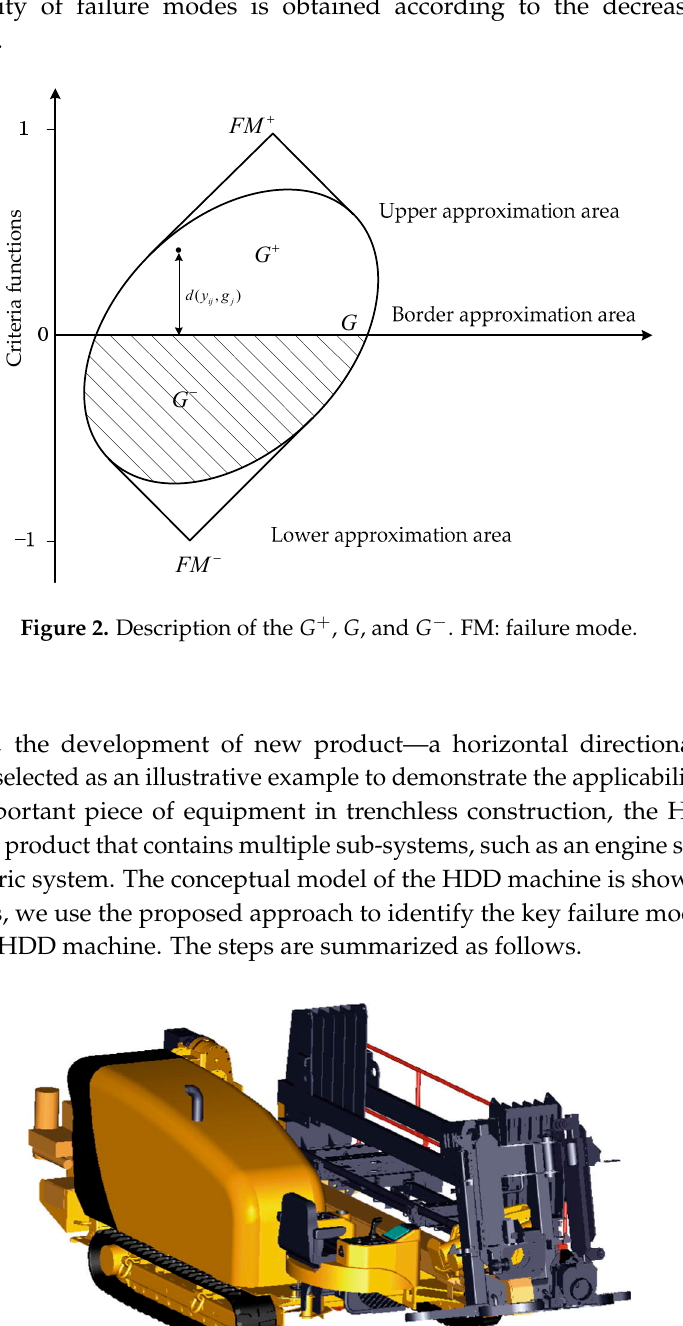
Figure 3. The conceptual model of the horizontal directional drilling machine [17].